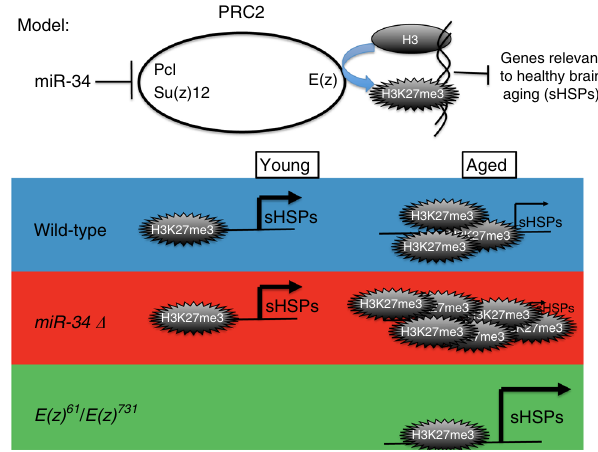
Fig. 9 Model for opposing activities of miR-34 and the PRC2 complex in aging. Our data suggest that miR-34 represses translation of Pcl and Su(z)12 transcripts, resulting in a reduction of PRC2 activity and less H3K27me3. In the miR-34 mutant and normally with age, H3K27me3 accumulates globally and at particular genes, resulting in decreased transcription. Some of these genes (the small heat shock proteins (sHSPs) are highlighted here) appear critical for healthy brain aging. Mutation of E(z) reduces the activity of PRC2, resulting in less suppression of sHSPs and a younger brain transcriptome pro fi le. These data indicate that reduction of the activity of PRC2 with age will be associated with healthier brain aging and protection from deleterious consequences to the brain with age,